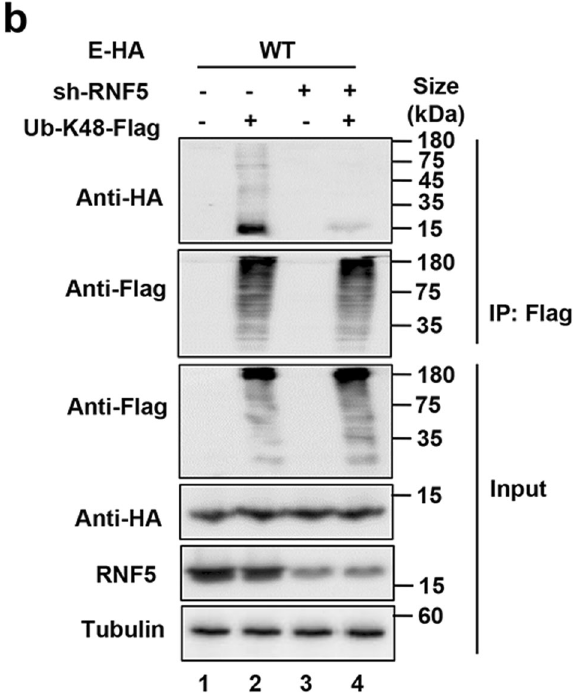
Fig. 3b Knockdown of RNF5 decreased K48-linked ubiquitination of E. (3) The plus signs and minus signs in Fig. 3e should line up with the lane.